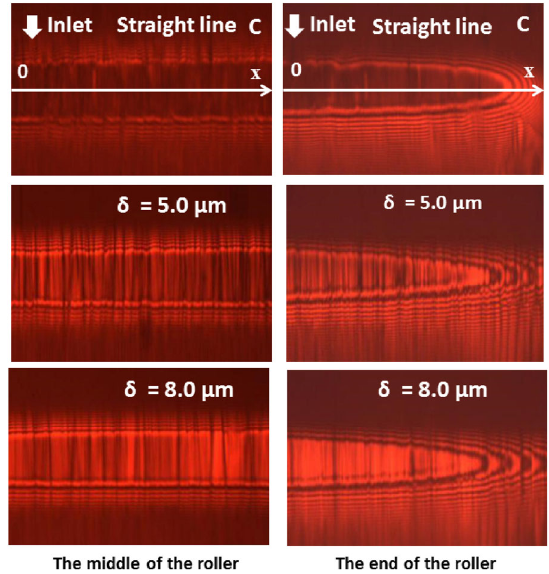
Fig. 8 Interference images captured using different profile rollers ( u = 15 mm/s, p max =0.58